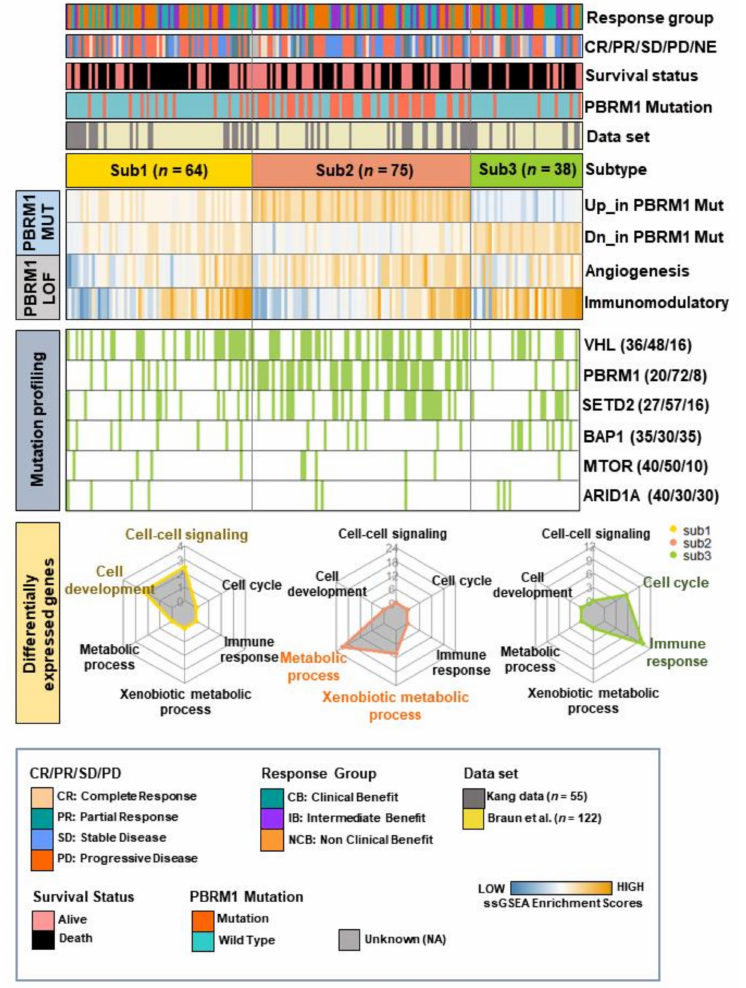
Figure 2. Characteristics of subtypes based on the gene sets associated with PBRM1 mutation and PBRM1 loss of function. Heatmap of the single-sample gene set enrichment analysis shows the enrichment scores of the four gene sets in the merged data set (top). Mutation plot shows six commonly mutated genes by overlapping recurrently mutated genes from both our data and the CheckMate 025 data (middle). (Green color denotes harboring mutation). Radar plots show significantly enriched gene ontology terms using upregulated genes in each subtype